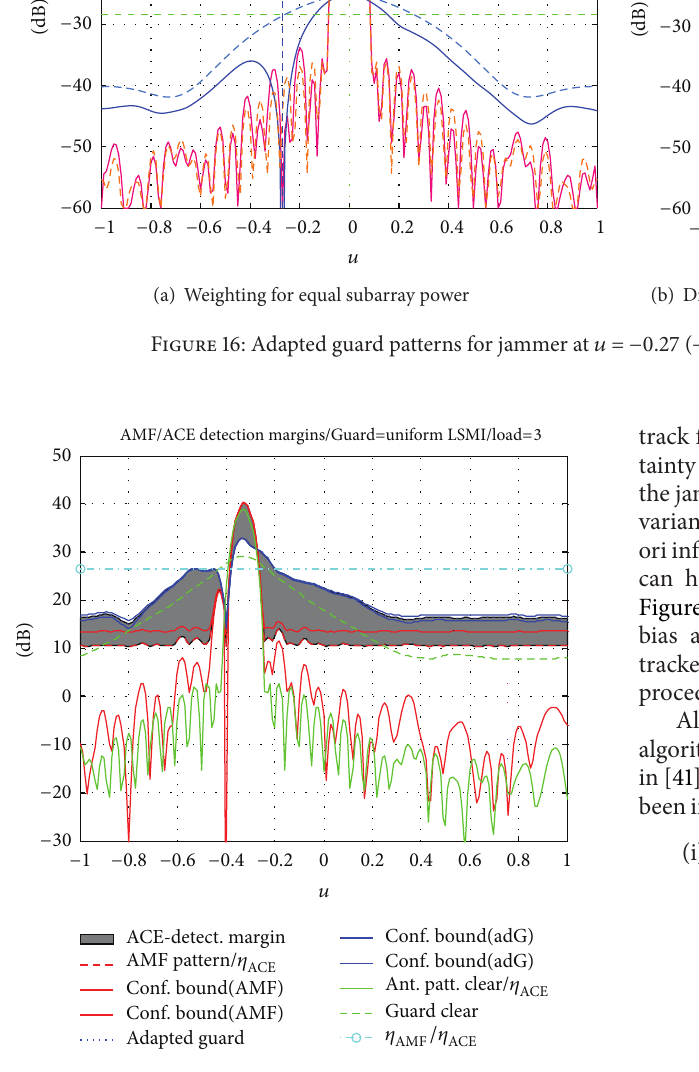
Figure 17: Detection margin (gray shading) between AMF and nonweighted adapted guard pattern with confidence bounds for ACE with LSMI (64 snapshots and 3𝜎 2 diagonal loading). Two CW interferences of 40dB INR are present at 𝑢 = − 0.8, −